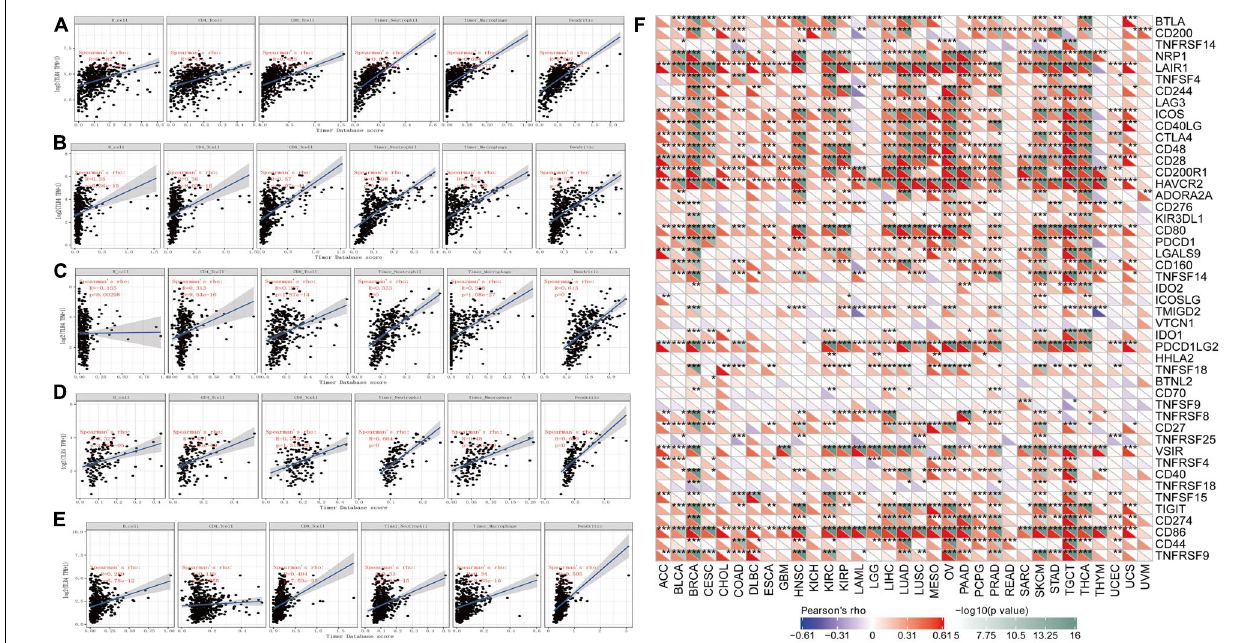
FIGURE 3 | Correlation analysis of TLR4 gene expression in immune infiltration, immune checkpoint, and in 33 tumors. (A–E) The expression of TLR4 was negatively correlated with the expression of B cells in STAD, KIRC, UCEC, TGCT, and SKCM. While the expression of TLR4 was positively correlated with the infiltration of B cells, CD4+ T cells, CD8+ T cells, neutrophils, macrophages, and dendritic cells in STAD, KIRC, UCEC, TGCT, and SKCM. (F) The results showed that the five prognostic-related cancers of KIRC, SKCM, STAD, TGCT, and UCEC are highly positively correlated with the six immune checkpoints of ICOS, CTLA4, CD28,